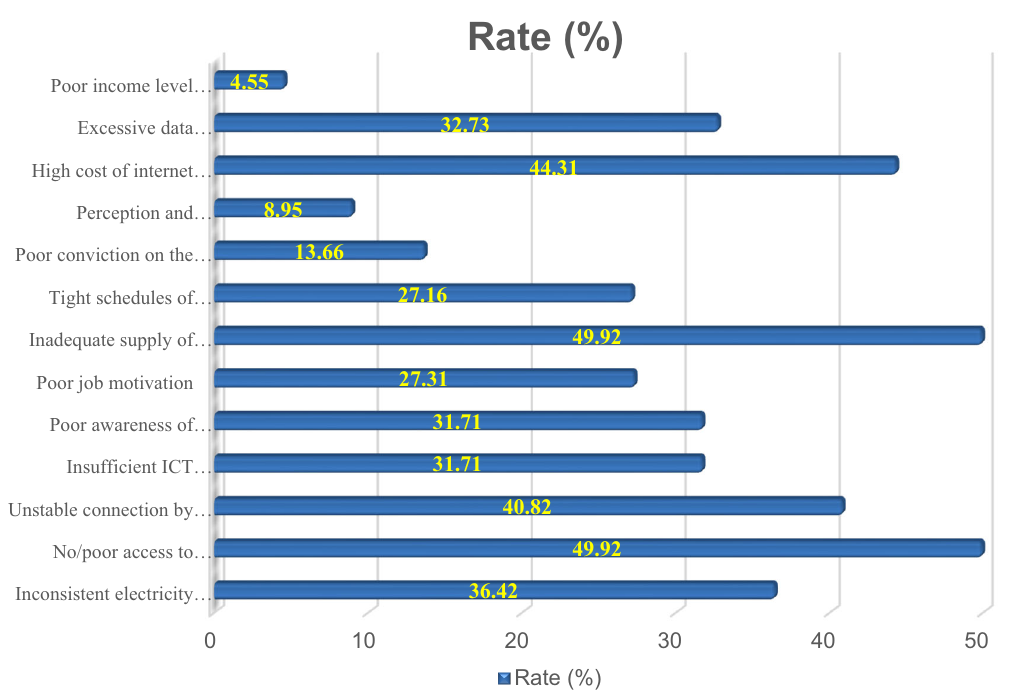
Figure 2. Bar chart showing the challenges faced by academics in the utilization of digital tools for research dissemination in African Universities.